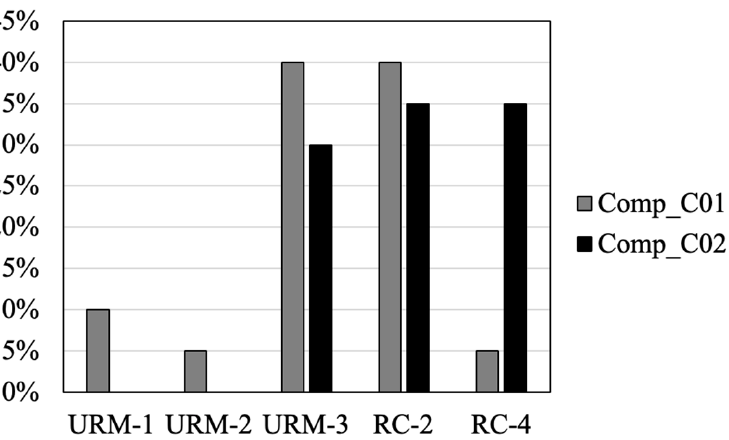
Figure 7. Distribution of the building classes surveyed in Scilla for the compartments C01 and C02.